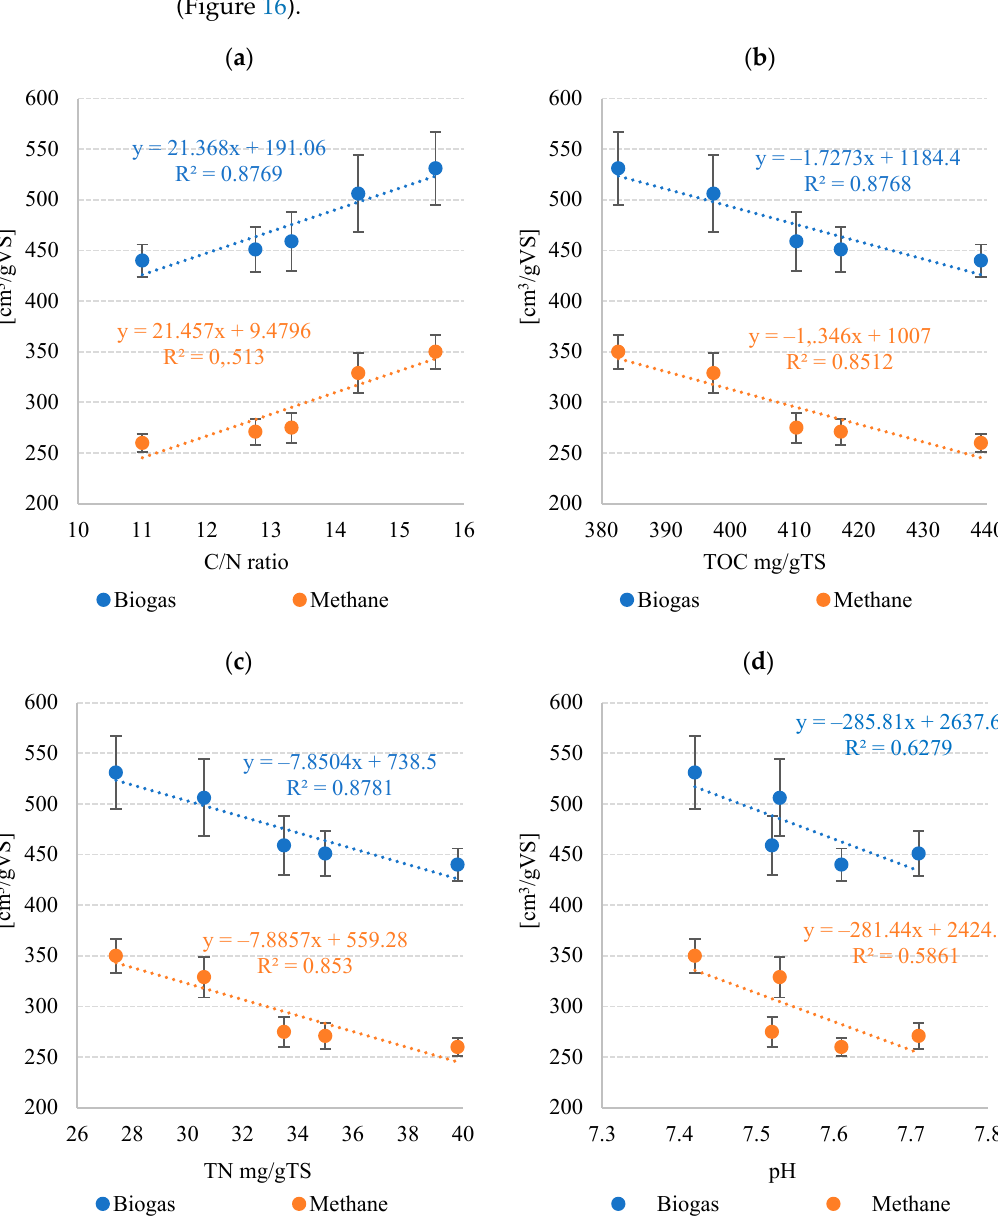
Figure 16. Correlations between selected biomass parameters (across growth phases) and bio- gas/methane yields: ( a )—C/N ratio, ( b )—TOC, ( c )—TN, and ( d )—pH.